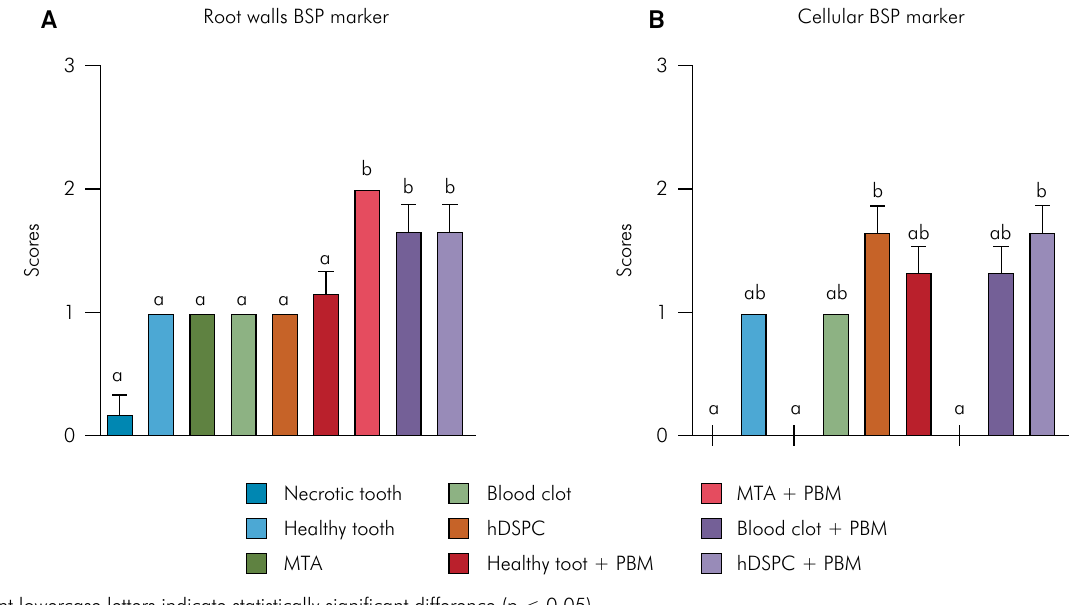
Figure 6. Graphic representation of the comparison between groups for immunoexpression of BSP marker for (A) Root walls BSP marker. (B) Cellular BSP